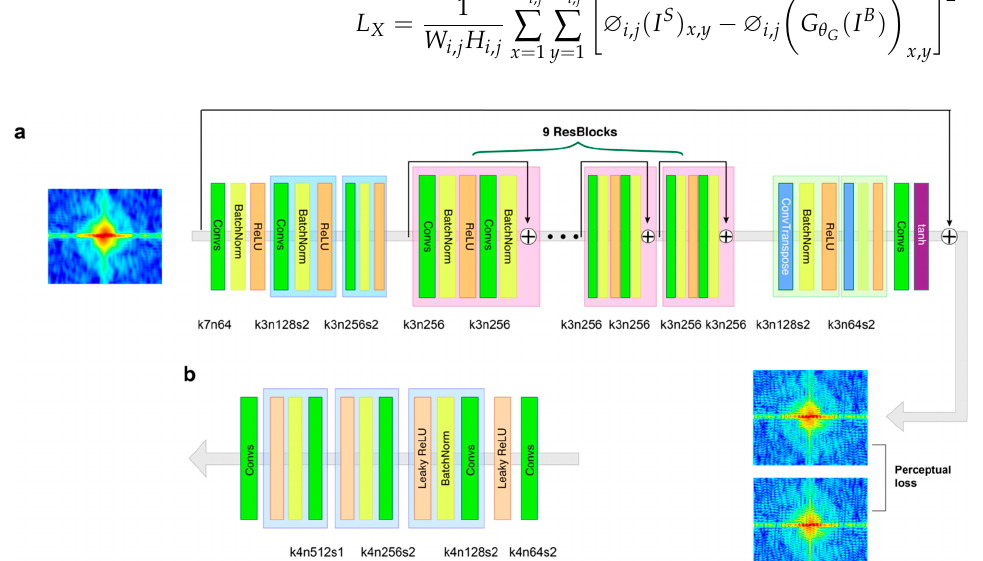
Figure 1. The conceptual architecture of the ( a ) generator and ( b ) discriminator with the correspond- ing number of kernel size (k), feature maps (n), and stride (s) indicated for each convolutional